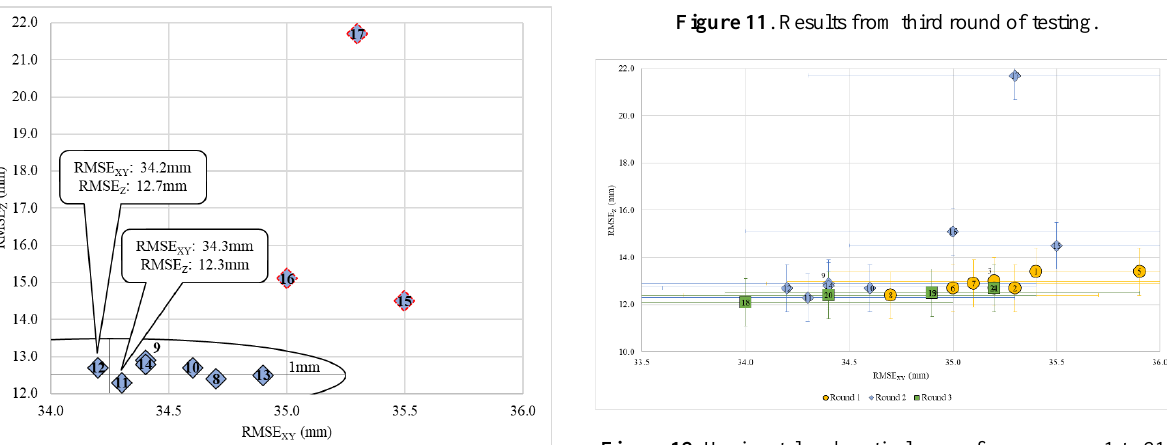
Figure 12 . Horizontal and vertical errors for sequences 1 to